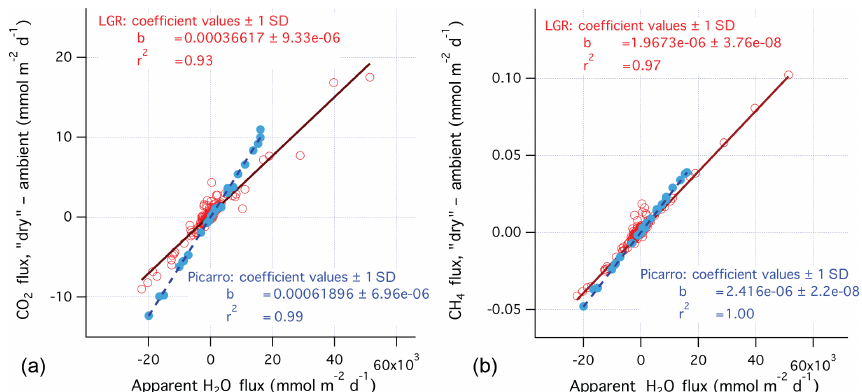
Figure 3. “Intra-instrument” difference in CO 2 (left) / CH 4 (right) fluxes computed from numerically dry and ambient CO 2 / CH 4 mixing ratios from the same instrument vs. apparent H 2 O flux (latter computed at the lag time of CO 2 / CH 4 ) . Both the LGR (red) and Picarro (blue) were directly sampling ambient air. Slopes ( b ) and r 2 values from the linear regressions are also shown.